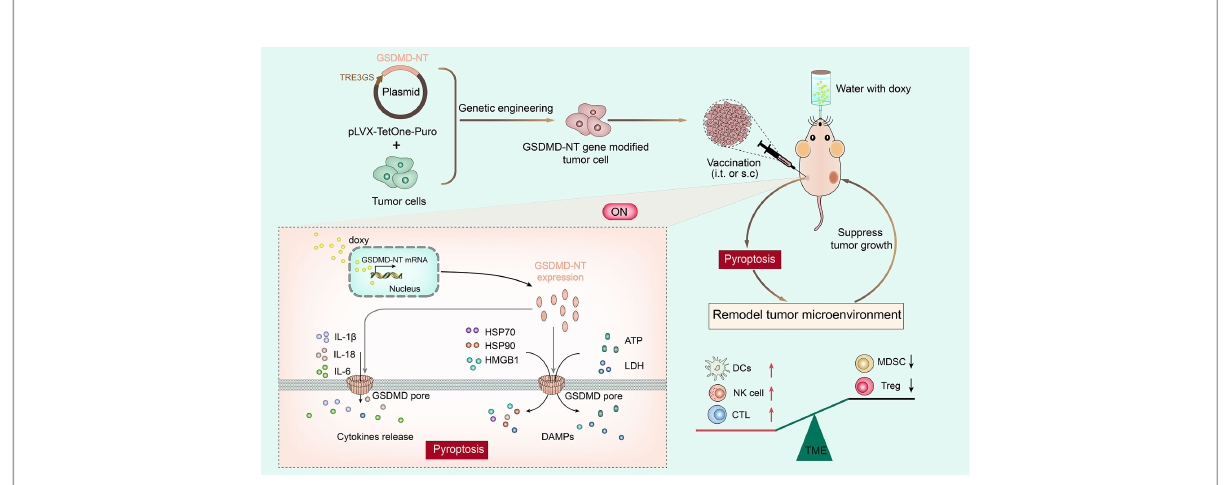
GRAPHICAL ABSTRACT Schematic representation of a personalized tumor vaccine strategy based on inducing GSDMD-NT genetically engineered tumor cells to in- duce pyroptosis and elicit antitumor immune responses. Tumor cells were genetically engineered to inducibly overexpress GSDMD-NT and in- duce pyroptosis as a novel personalized tumor cell vaccine. After inoculation of mice with the cells, GSDMD-NT was induced to be expressed by providing drinking water with doxy, and it oligomerized on the cell membrane to form pores. Cell swelling and pyroptosis occur with the re- lease of in fl ammatory molecules, and danger signals including HMGB1, ATP, LDH, CART, and HSP70/90. These DAMPs stimulate the migration and maturation of DCs, and promote the production of tumor-speci fi c CD8+ T cells and IFN-g, accompanied by downregulated